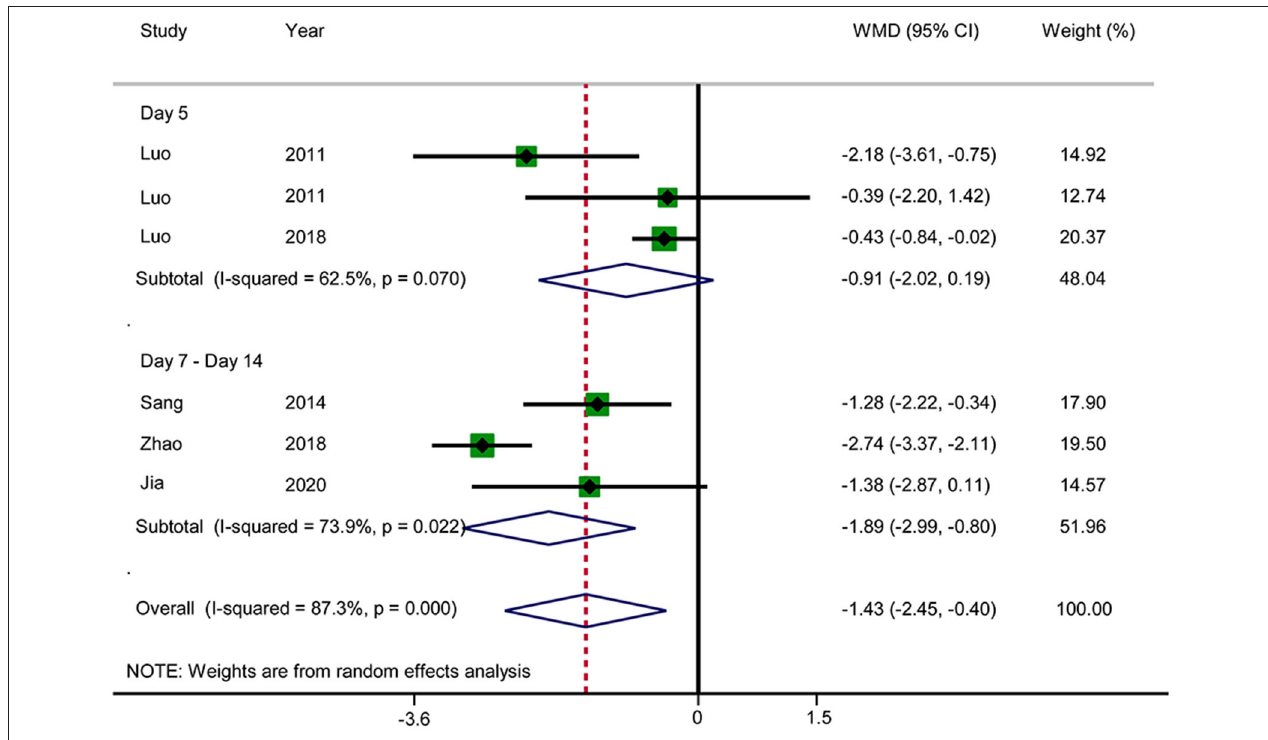
FIGURE 11 | Meta-analysis of APACHE II